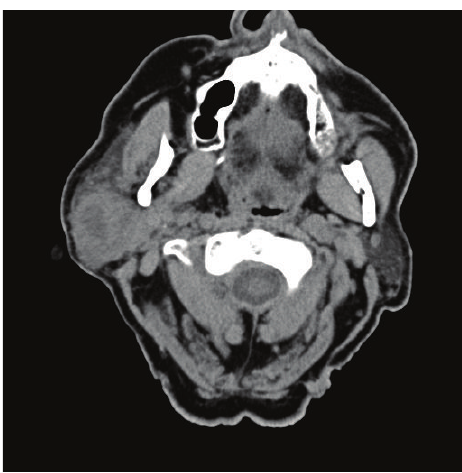
Figure 1: Preoperative CT scan.